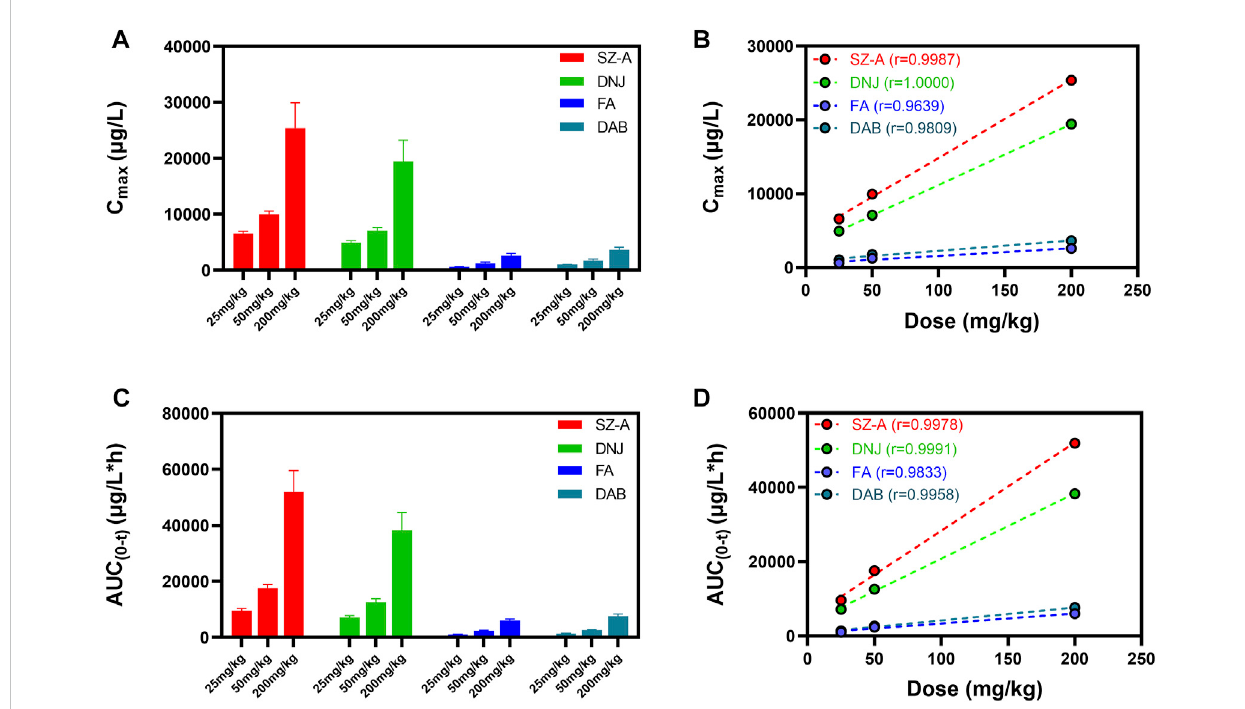
FIGURE 3 The linear relation between C max and the SZ-A dose (A,B) and between AUC and the SZ-A dose (C,D) . Each value represents the mean ± standard error of mean (SEM) ( n =